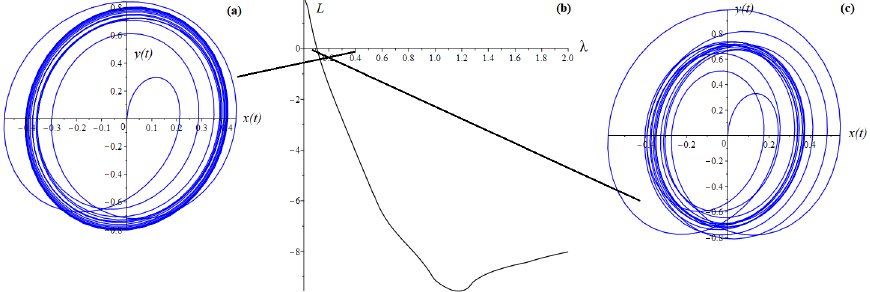
Figure 13. ( a ) Phase trajectories at λ = 0.1, ( b ) the spectrum of Lyapunov exponents from λ and ( c ) phase trajectories at λ =